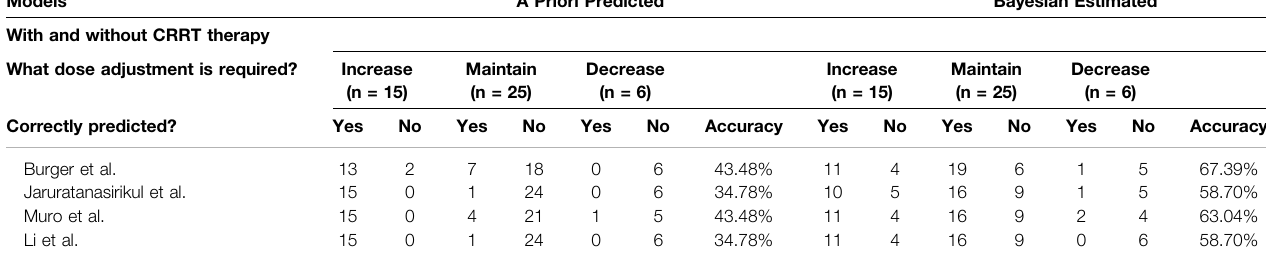
TABLE 3 | Predictions of the need for dose adjustments based on the target of 100% f T > 4×MIC (MIC = 2 mg/L) according to meropenem concentrations following the second occasion (n = 46) in a priori estimation and Bayesian estimation. Models A Priori Predicted Bayesian